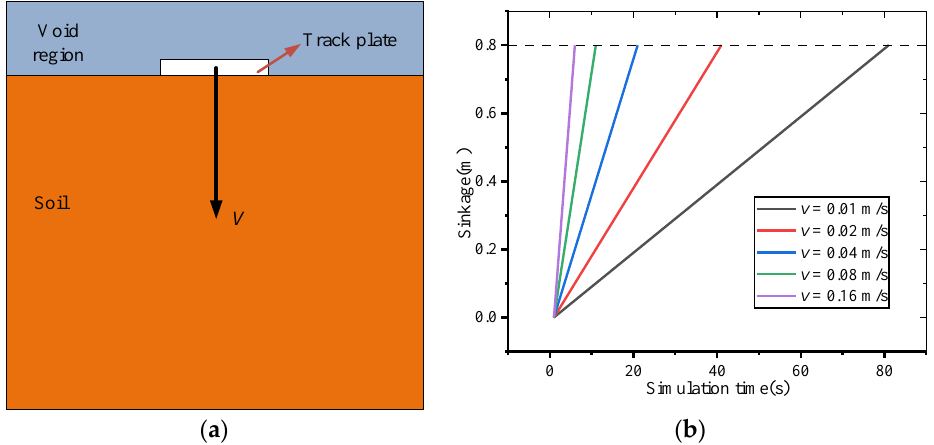
Figure 14. ( a ) Schematic diagram of numerical simulation and ( b ) curve of different velocities.